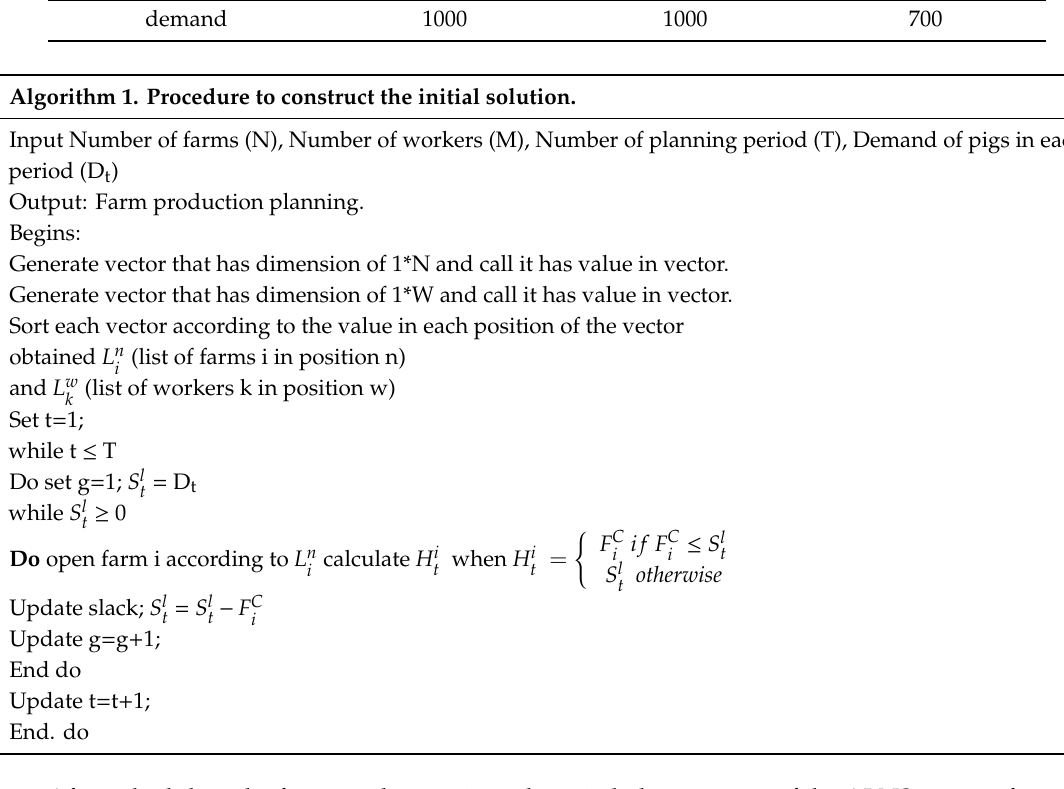
Algorithm 1. Procedure to construct the initial